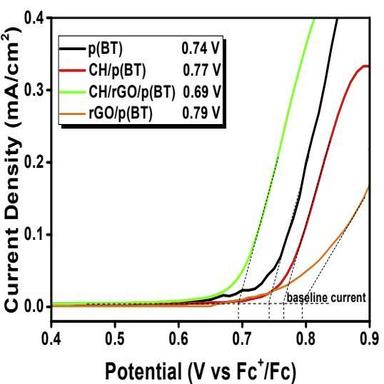
Anodic polarization curves of p(BT), CH/p(BT) and CH/rGO/p(BT).